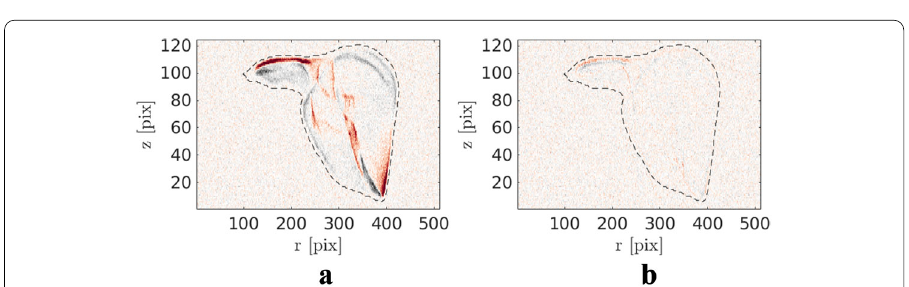
Fig. 5 Measured displacement fields of the five first modes (cid:2) PGD i in the x,y,z directions (here shown on the numerical mesh yet computed on the boxed mesh composed of 81 space degrees of freedom). The amplitude is to be associated with the 1500 time amplitudes normalized angle-wise